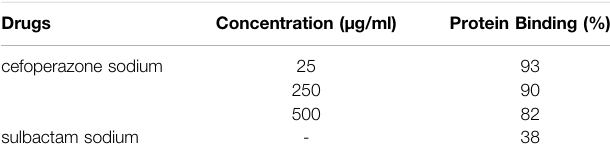
TABLE 3 | The protein binding rates of cefoperazone sodium and sulbactam sodium to human plasma proteins. Drugs Concentration ( μ g/ml) Protein Binding